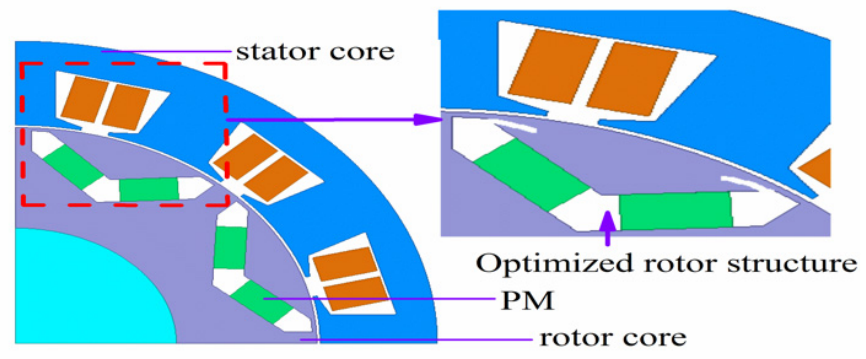
Figure 1. Finite element model of V rotor of PMSM. Table 1. Main parameters of permanent-magnet motor.